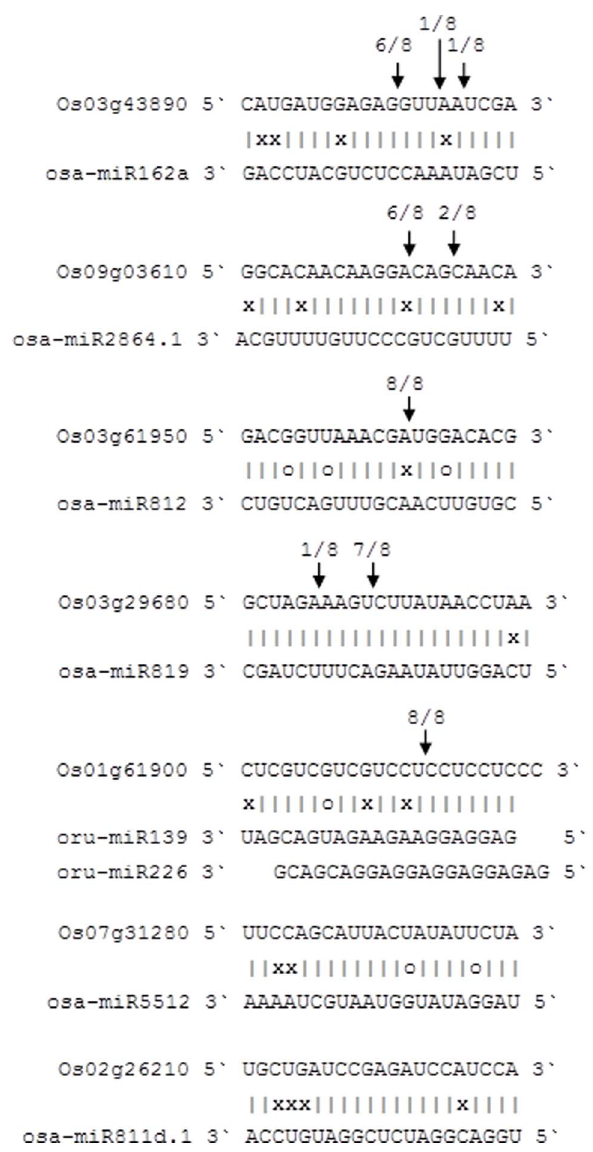
Figure 6. Mapping target mRNA cleavage sites by RNA ligase- mediated 5 9 -RACE. The arrows indicate the cleavage sites and the numbers show the frequency of clones sequenced.